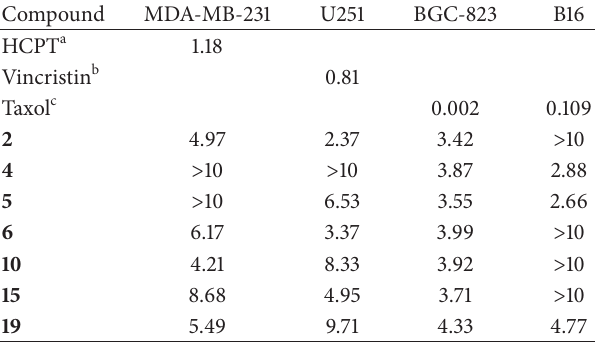
Table 1: IC 50 value ( 𝜇 g/mL) of chalcones and deoxyflavonoids on the cancer cell